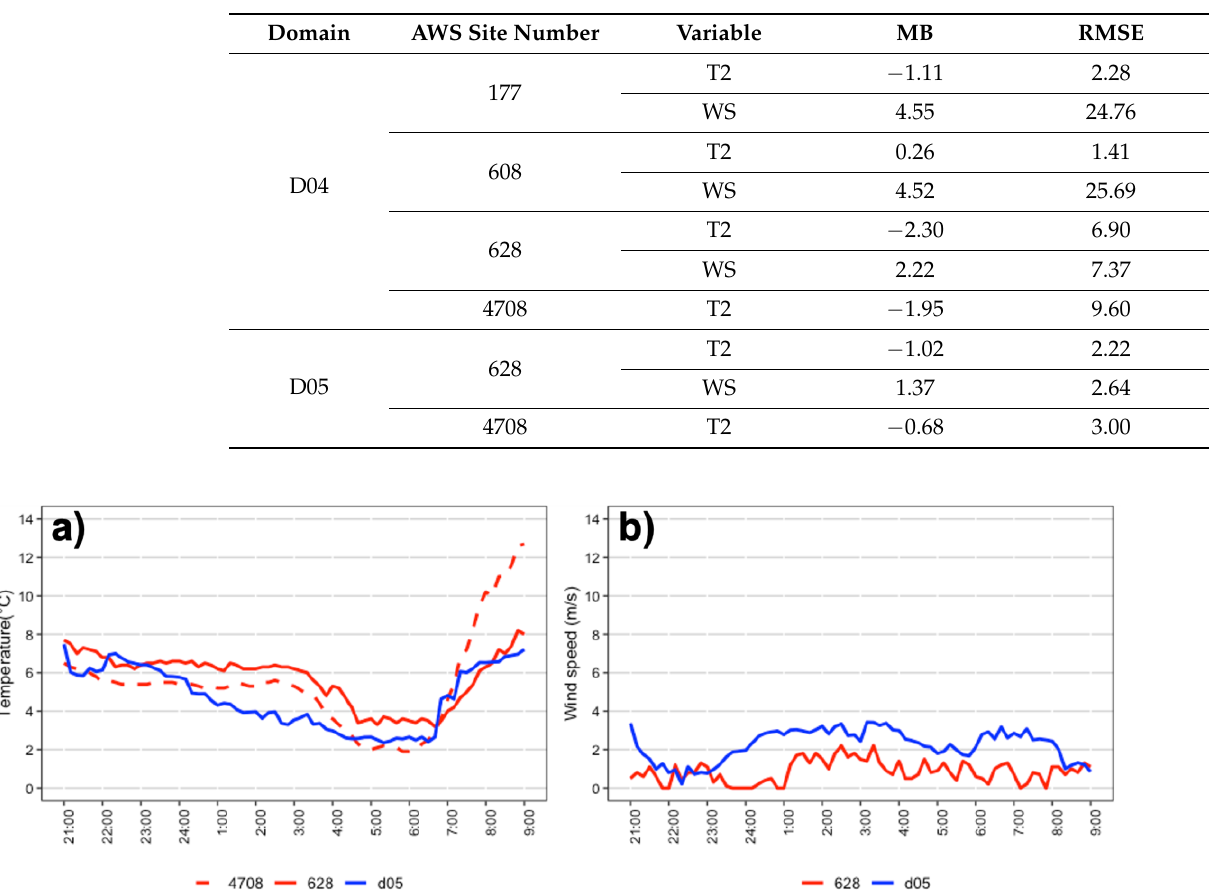
Figure 10. Comparison of time series of observed data at AWS (#4708 and #628) and WRF–LES simulation in domain 5 for Case 2. ( a ) The 2-m air temperature (°C) and ( b ) wind speed (m/s). Table 4. Performance of WRF–LES simulation for Case 2.